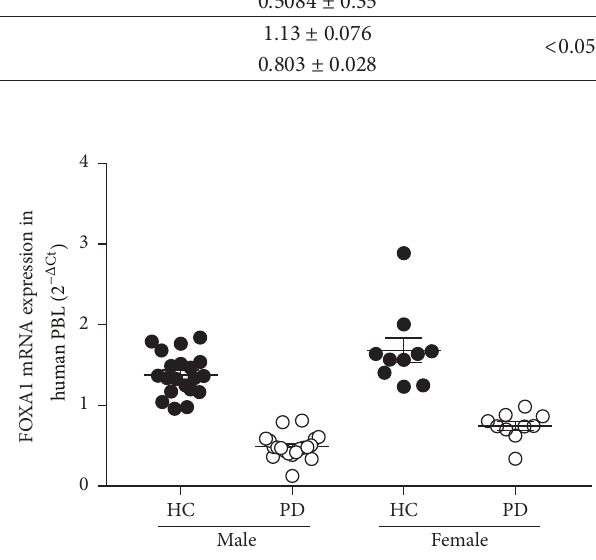
Figure 1: Scatter plot showing NURR1 mRNA expression on PBL in different study groups. Fluorescent reading from Q-PCR was quantitatively analyzed by determining the difference of Ct between Ct of NURR1 and 𝛽 -actin. mRNA expression was determined by using the formation of 2 −Δ Ct . Bars represent mean ± SME measured from duplication assay in blind fashion. 𝑝 < 0.05 .